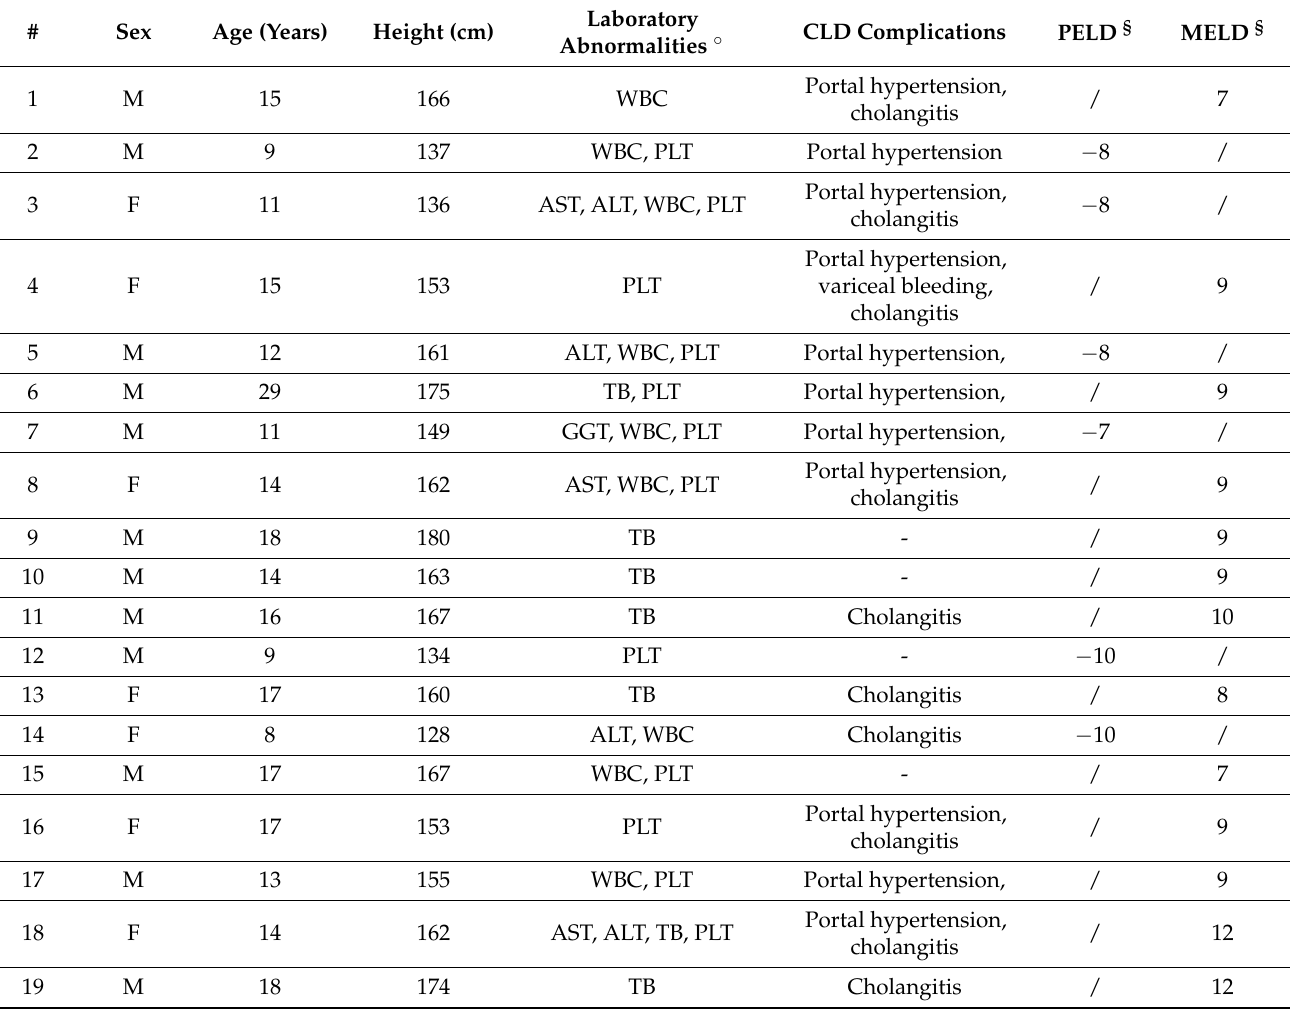
Table 4. Laboratory and clinical findings of the patients in Group